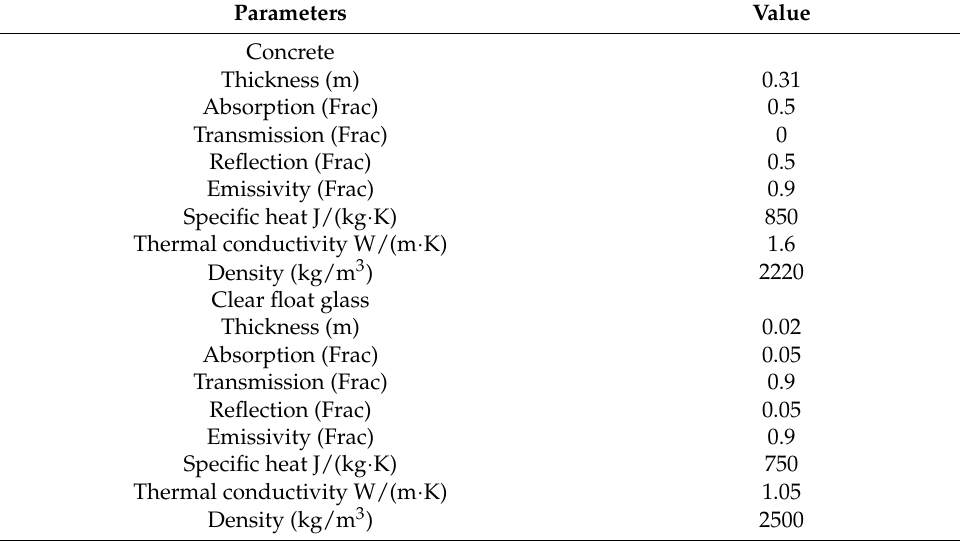
Table 3. Properties of concrete and